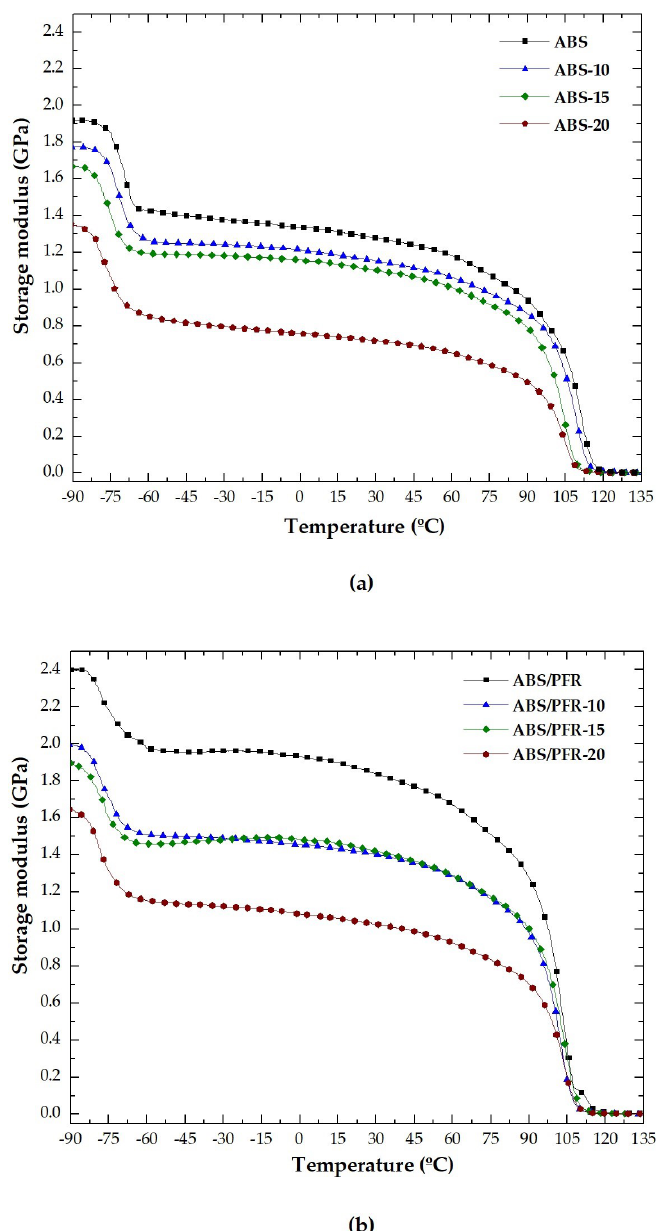
Figure 5. Evolution of the storage modulus with temperature for unfoamed and foamed ( a ) ABS and ( b )